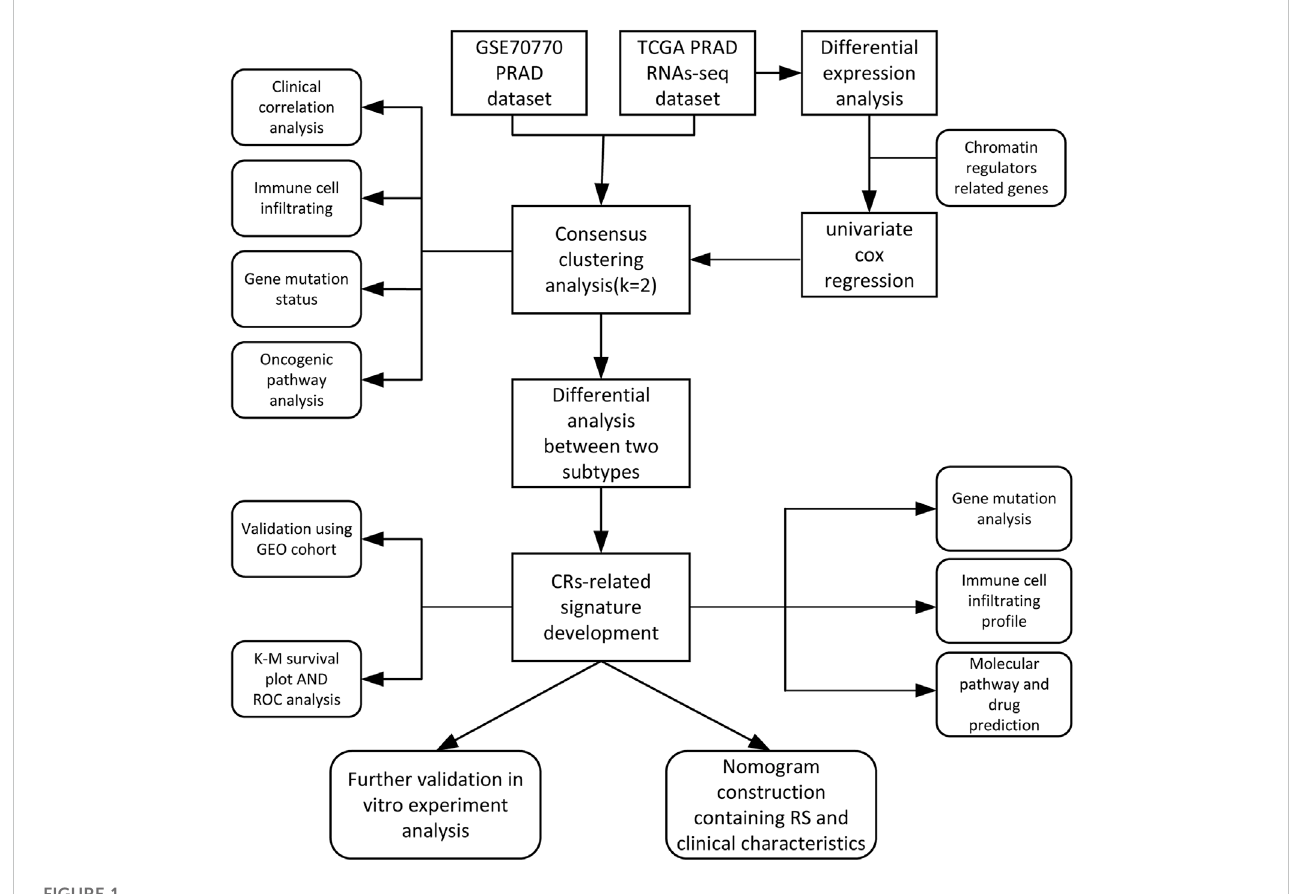
FIGURE 1 The main analysis work fl